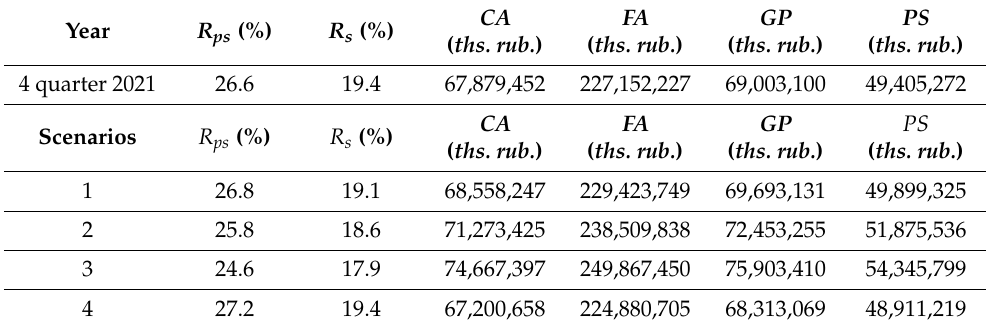
Table 13. Scenarios of changes in enterprise efficiency (exponential activation